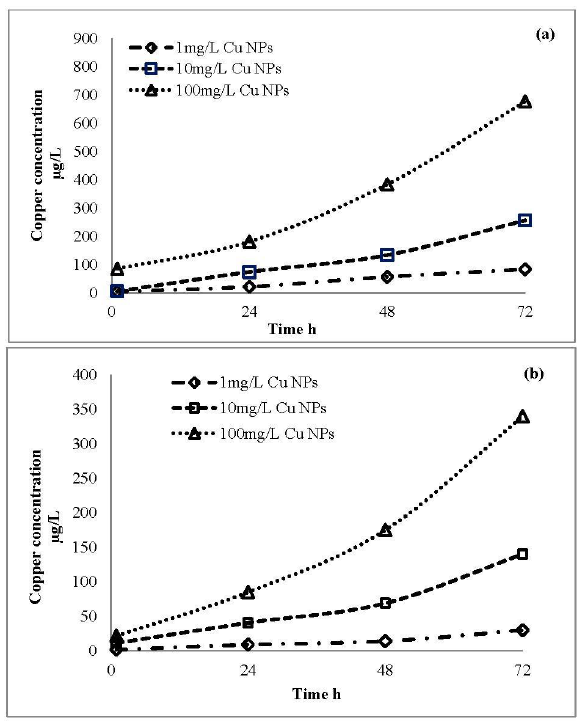
Figure 9. Copper ion release ( a ) engineered CuO nanoparticles and ( b ) plant-synthesized CuO nanoparticles (Mean ± standard deviation (SD) ( n = 3)).